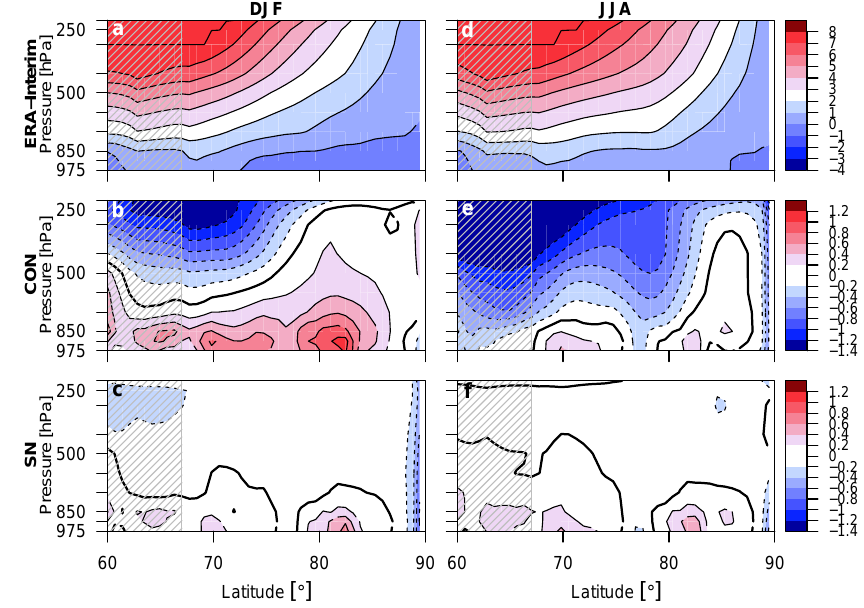
Fig. 5. Same as Fig. 4, but for zonal mean zonal winds, and units in m/s.